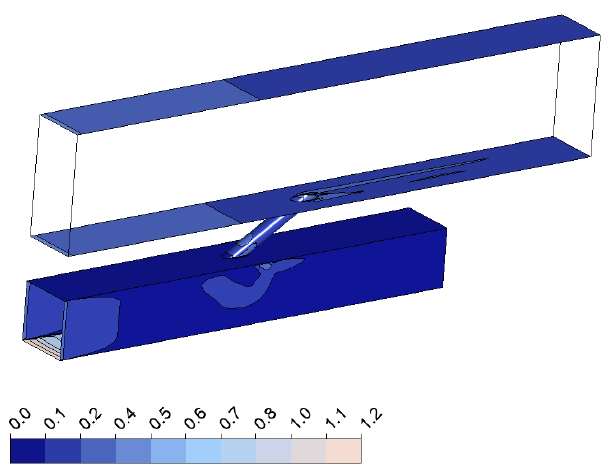
Figure 5. y + contours distribution on the walls.